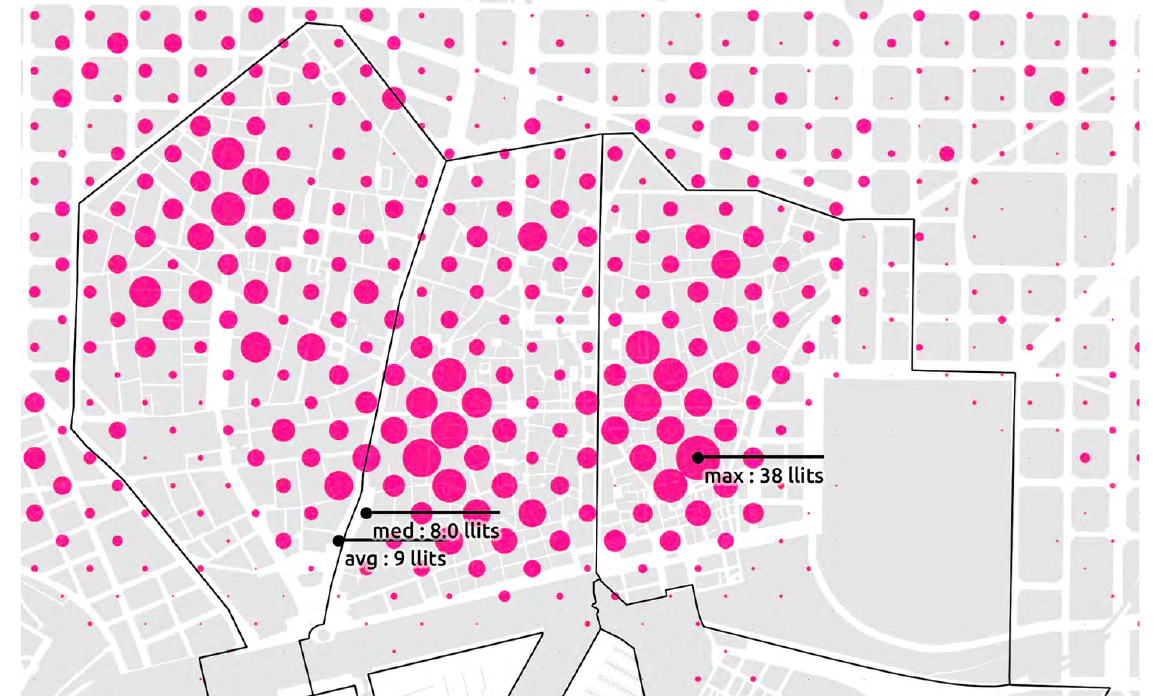
Figure 8. Agglomeration areas of rooms for rent on Airbnb with tourism license. Source: Trescientosmil kms (2017). Urban Planning, 2018, Volume 3, Issue 3, Pages